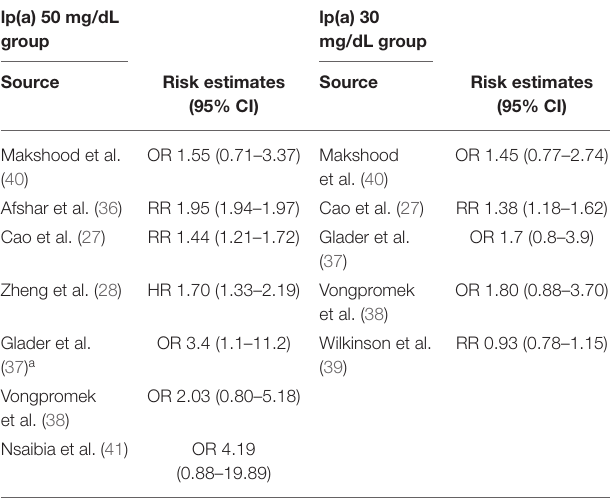
TABLE 2 | The statistics of included studies.